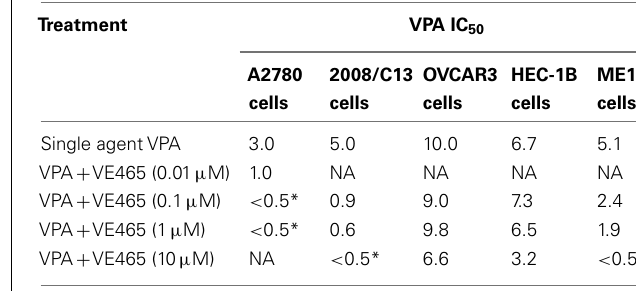
effects in the gynecologic cancer cell lines. The IC 50 values for VPA were between 3.0 and 10.0 mM; the values for VE465 were between 0.1 and 58.3 µ M ( Table 1 ).